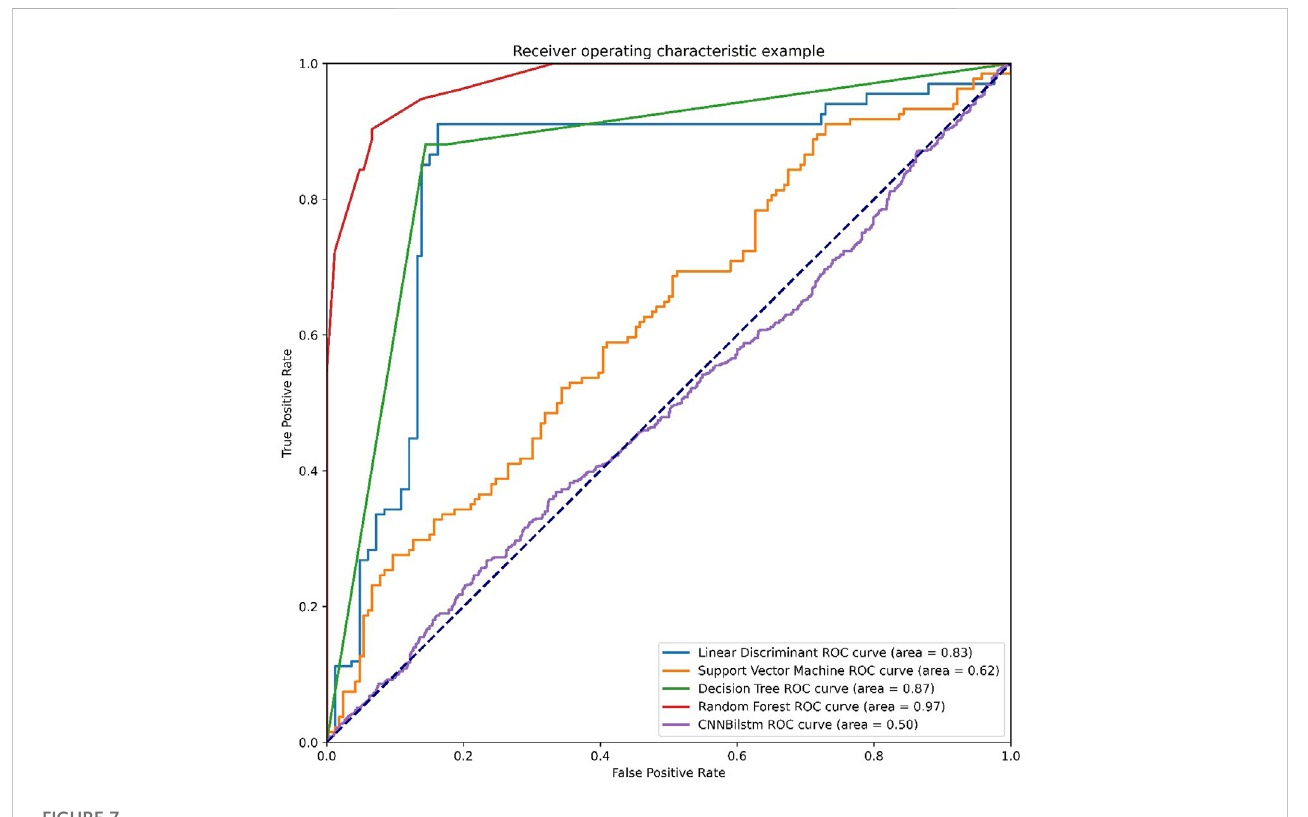
FIGURE 7 The ROC curves of combination feature.